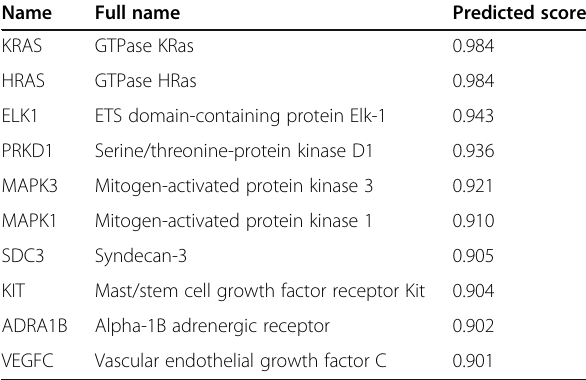
Table 4 Prediction of human PRRT2 gene promoter region by Table 2 Ten proteins predicted to interact with human